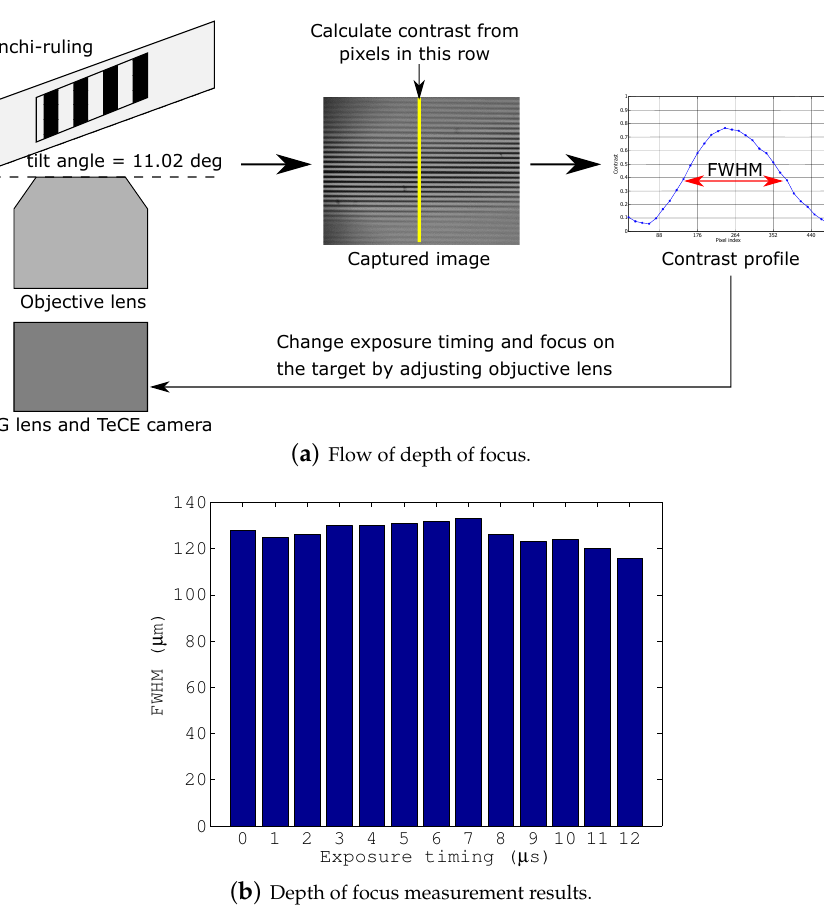
Figure 5. Measurement procedure and results for depth of